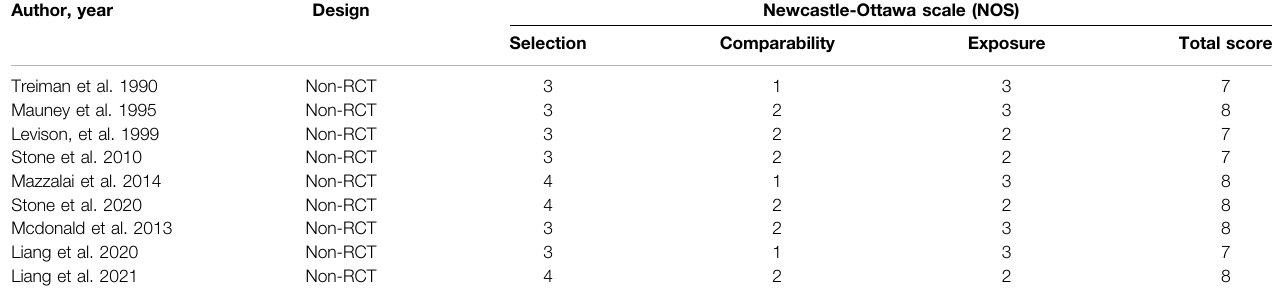
TABLE 3 | The quality assessment in randomized controlled trials.